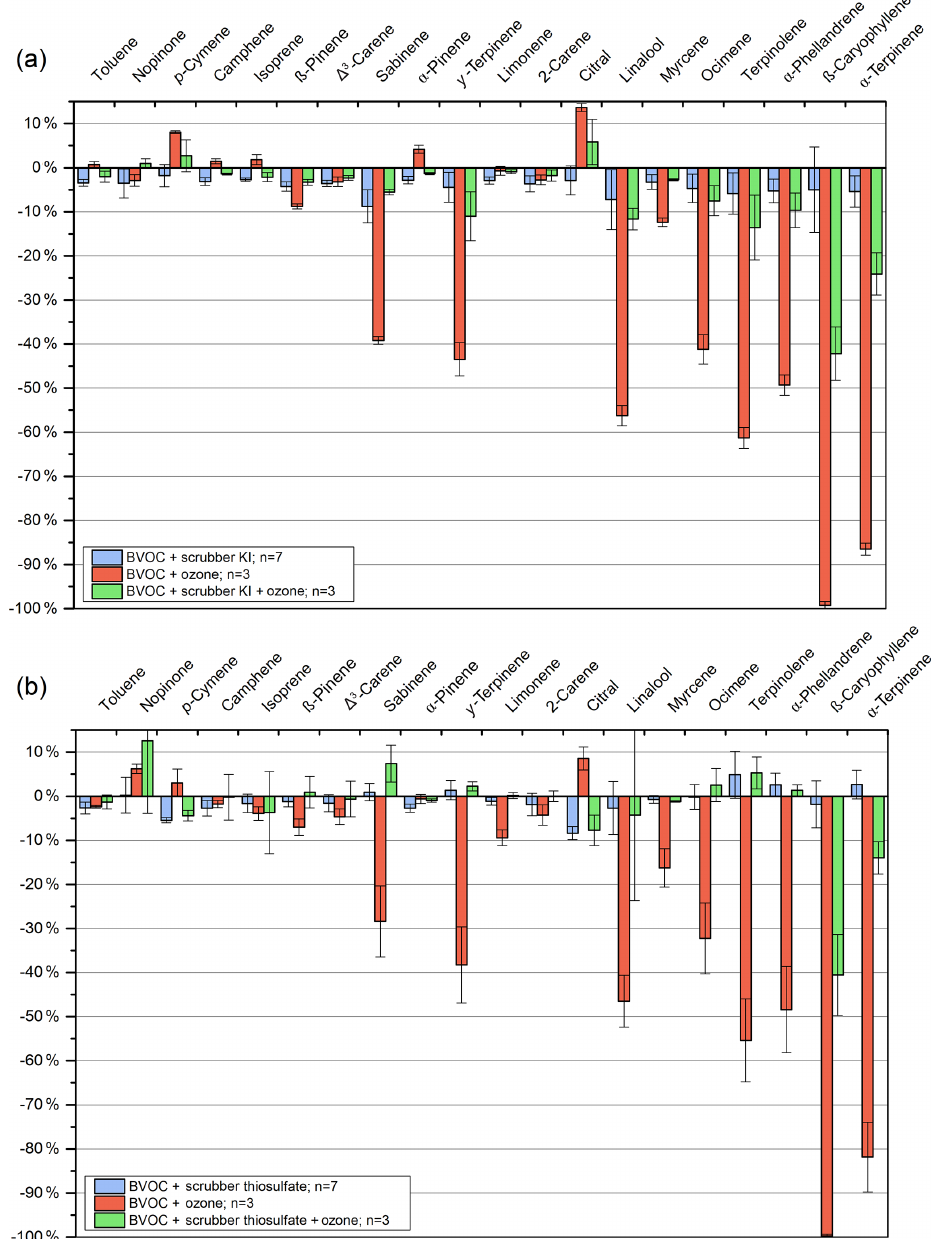
Figure 5. Relative deviation of BVOC measurements performed (i) with a scrubber and without O 3 , (ii) when O 3 (50ppb) is added to the standard mixture without scrubber, and (iii) when a scrubber is used with O 3 . (a) KI scrubber and (b) thiosulfate scrubber. VOCs are classified from the less reactive (left) to the most reactive (right) with ozone. Errors bars correspond to 3 standard